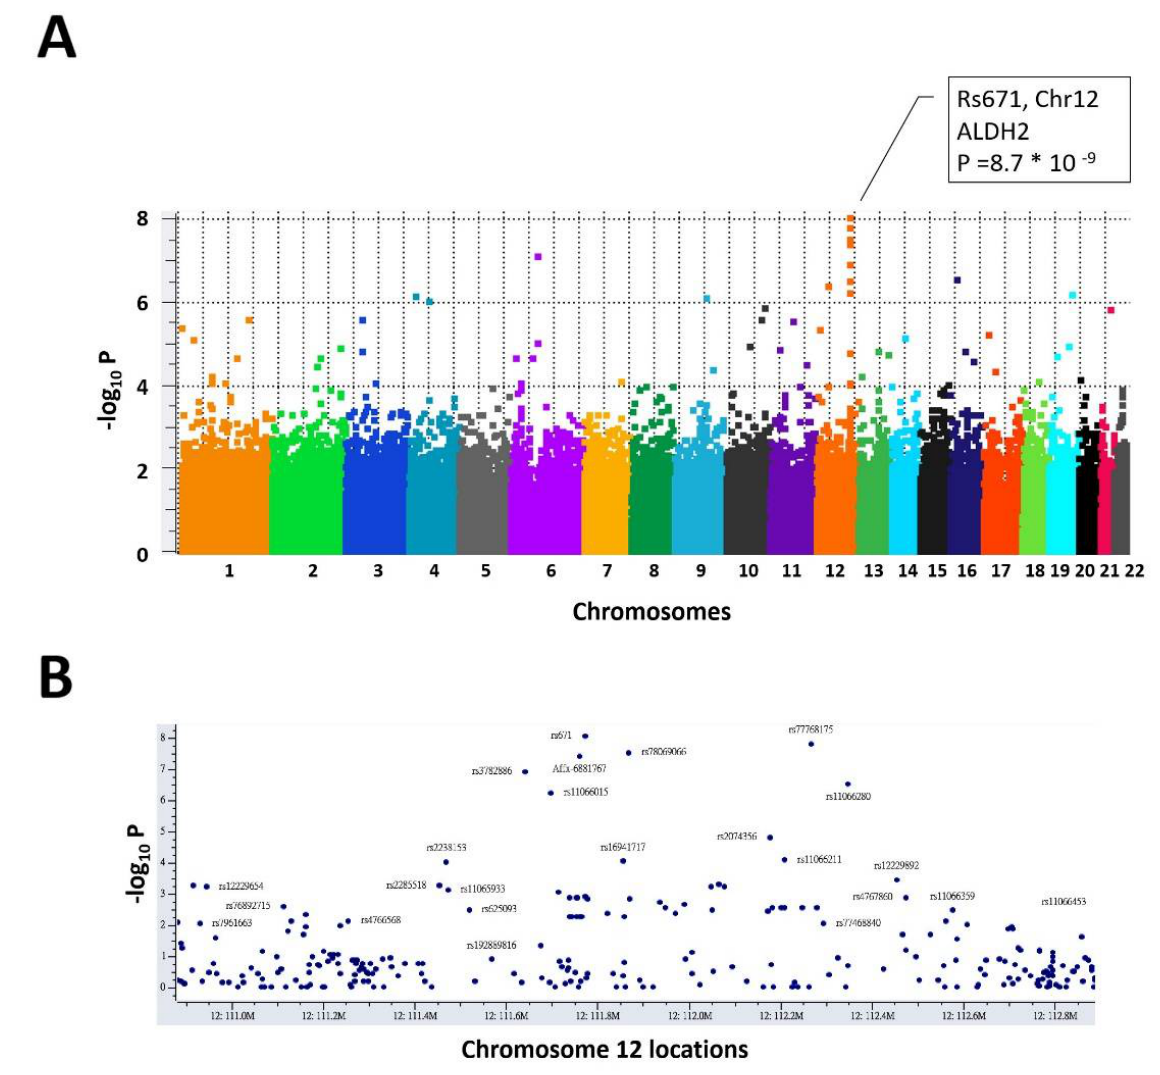
Figure 1. Genome-wide comparisons of residents in Keelung who drank hazardously and who did not drink in their daily life. ( A ) Manhattan plot of autosomal chromosomes. ( B ) Zoom-in plot of association in the vicinity of rs671 (2 million nucleotide bases; Chr12:110,912,851-112,927,816 in GRCh38).